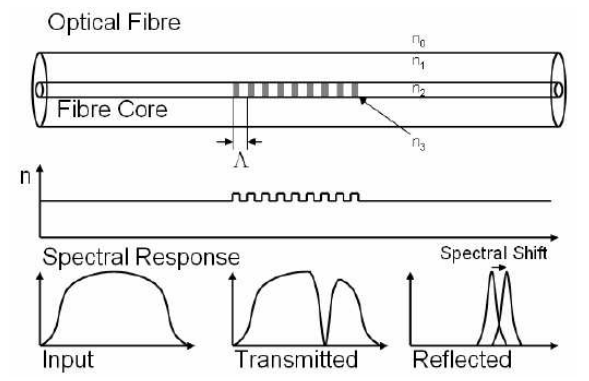
Fig. 1. Fiber Bragg Grating